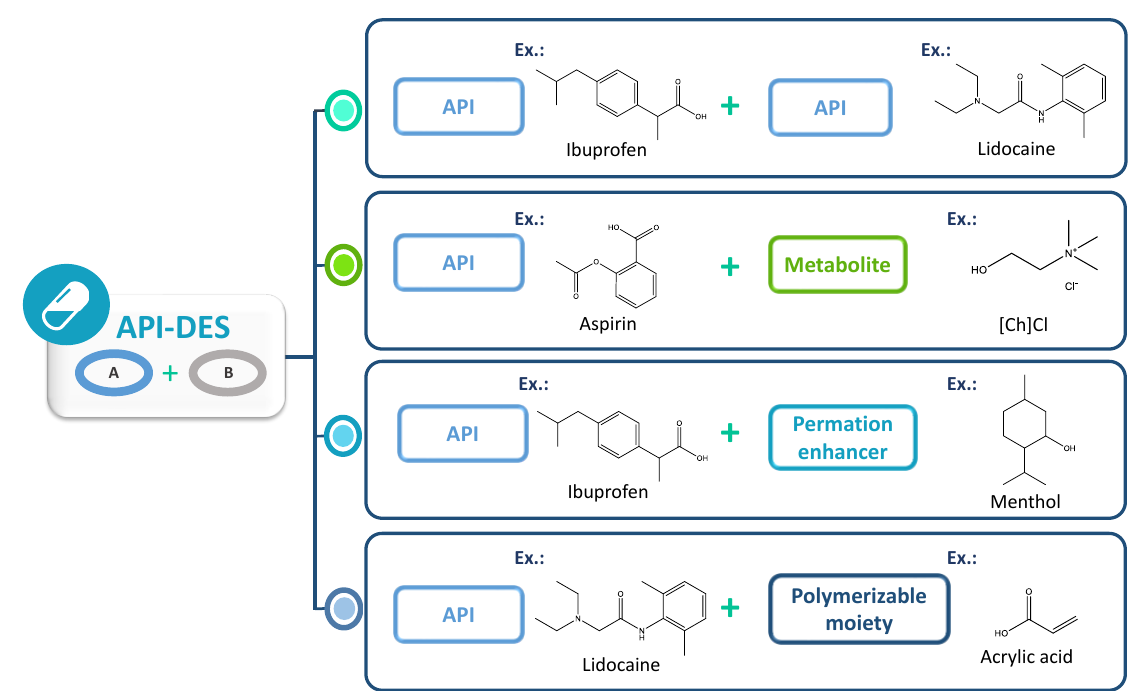
Figure 4. Possible API–DES strategies according with the forming components selection.